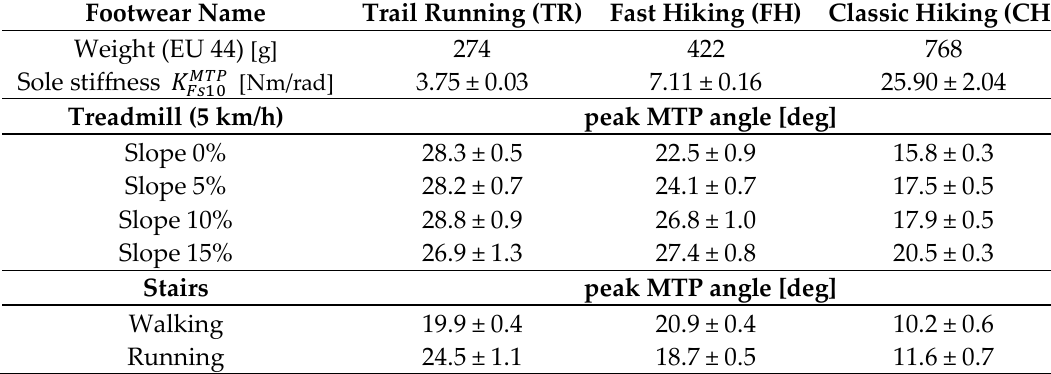
Table 1 . Results summary. The standard deviation of the peak MTP angle relative to the values of treadmill walk is calculated between subjects, while the one relative to the stair climb is calculated between repetitions of the same